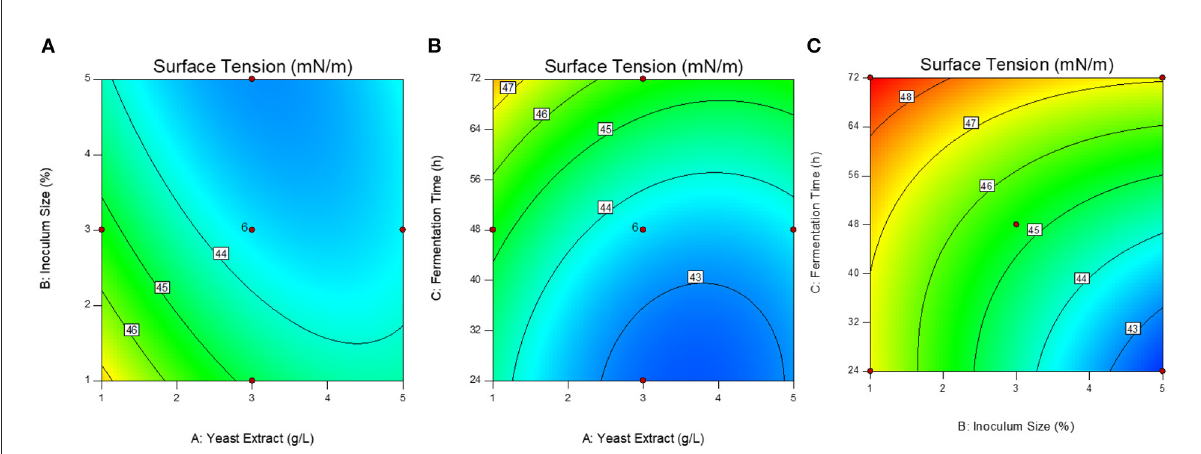
FIGURE1 Response surface contour plots showing the interactive effect of variables on the surface tension. (A) Yeast extract g/L: inoculum size % (AB); (B) Yeast extract g/L: fermentation time h (AC); (C) Inoculum size %: fermentation time h